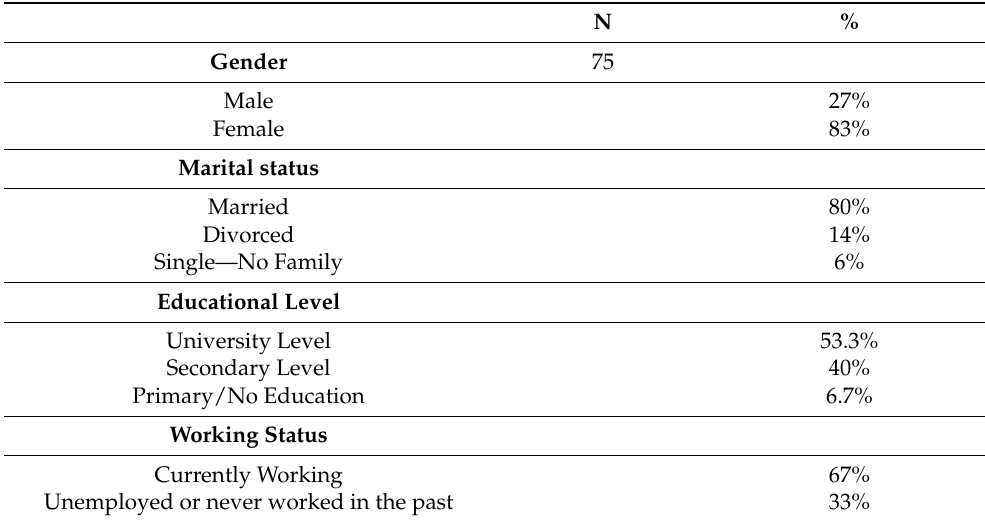
Table 1. Parents’ Demographic